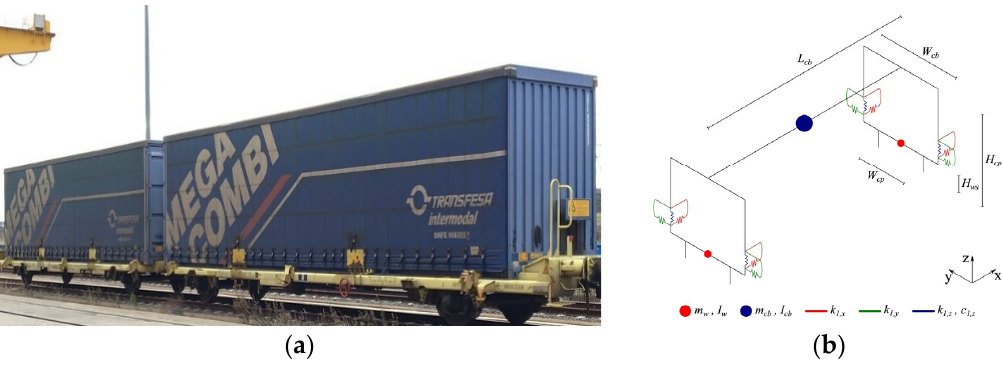
Figure 1. Laagrss type freight wagon: ( a ) double wagon overview; ( b ) numerical model.